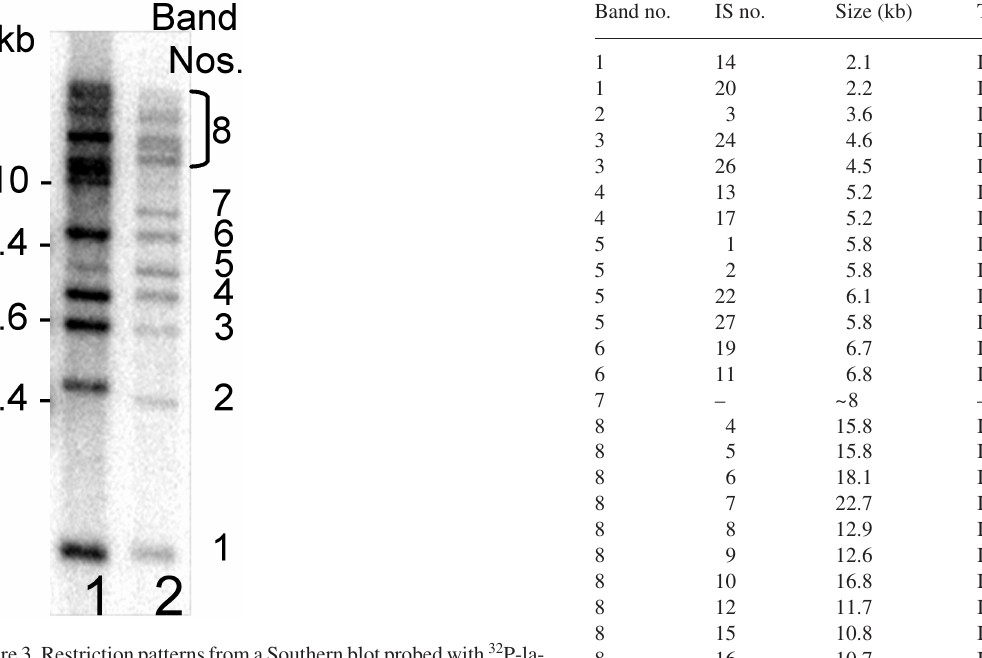
Figure3. Restrictionpatternsfroma Southernblotprobed with 32 P-la- beled tnp DNAs. The DNA from P. woesei (lane 1) and P. furiosus (lane 2) were completely digested with Pst I restriction enzyme. Size markers in kilobases (kb) are shown on the left of the Figure. Band numbers were assigned only to the bands from P. furiosus and are shown on the right of the figure. Intensities of bands and indices were